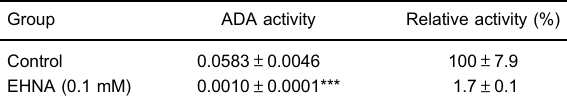
Table 2. Adenosine deaminase (ADA) inhibition in human lymphocyte-rich peripheral blood mononuclear cells by